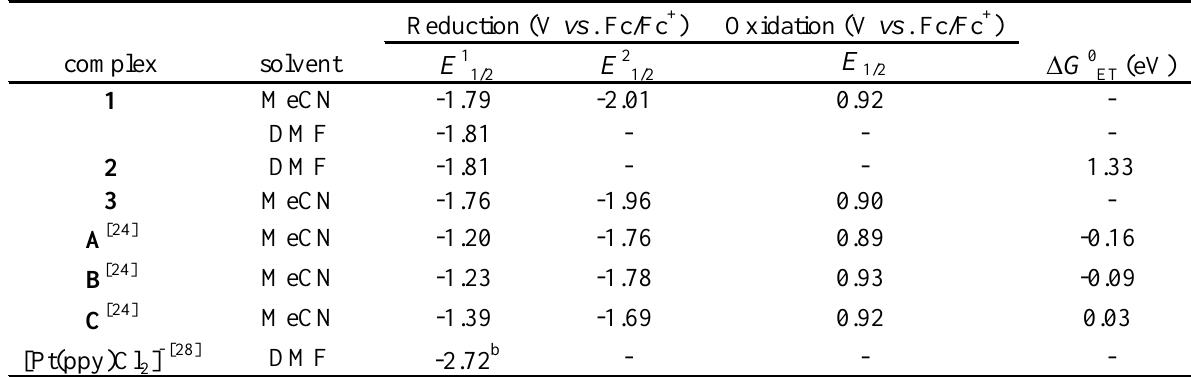
Table 2. Electrochemical data a of 1 - 3 and A - C